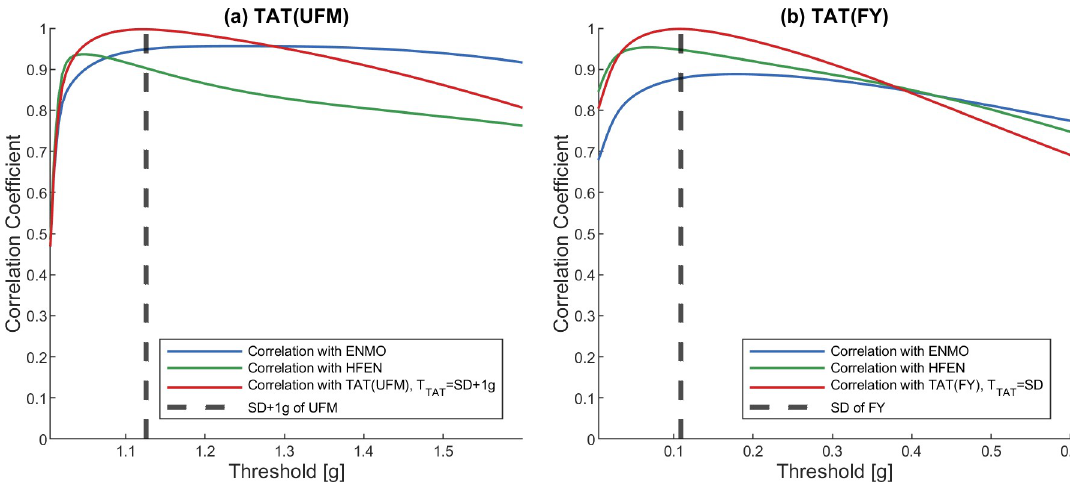
Fig 6. Correlation between TAT activity signal and activity signals based on other metrics using different TTAT thresholds in the case of UFM (a) and FY (b) datasets. The datapoints of the correlation curves as well as the SD of the datasets were based on the mean of 42 measurements. On each panel, the correlation curves show the Pearson’s correlation coefficients between the TAT activity signals calculated with the given TTAT threshold value (x-axis) and the ENMO activity signal, the HFEN activity signal, the TAT activity signal calculated using the SD+1 g (a) or SD (b) of the dataset as